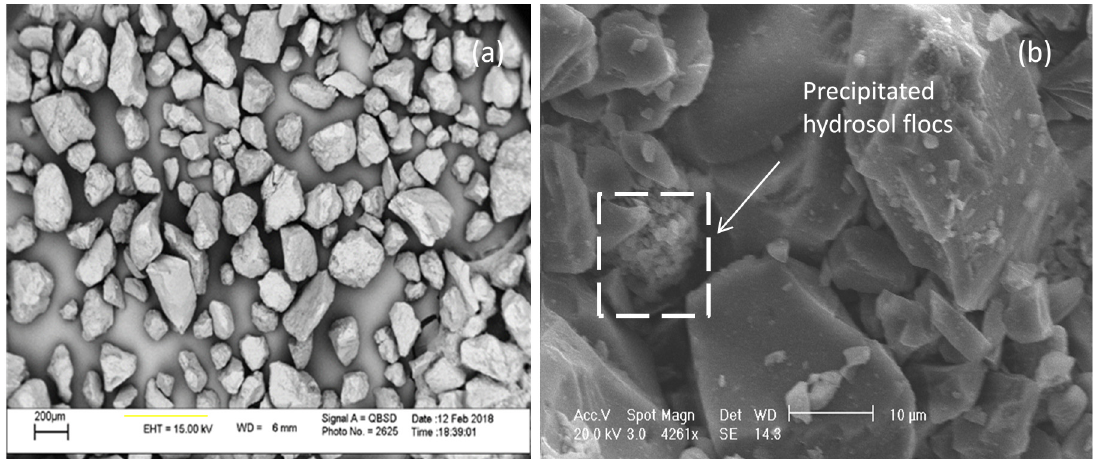
Figure 2. Shape on secondary electron micrograms: ( a ) sub-angular F161 sand particles; ( b ) rounded hydrated amorphous NS flocs.